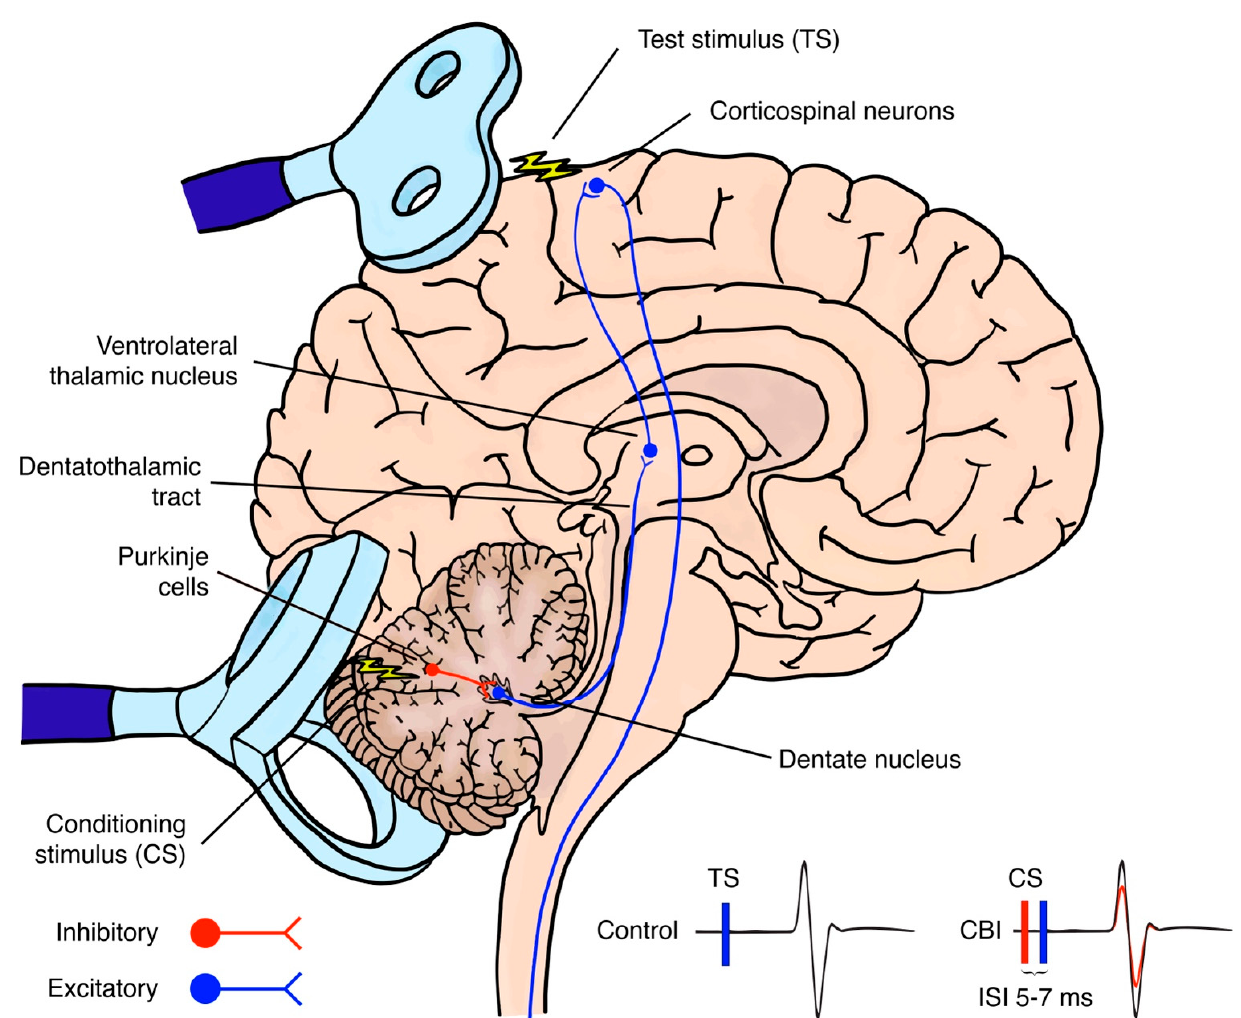
Figure 1. Midsagi tt al section illustrating the cerebellar brain inhibition paradigm. This paired-pulse transcranial magnetic stimulation protocol assesses the physiological inhibitory tone of the cerebellar cortex over the contralateral primary motor cortex. Specifically, the administration of a conditioning stimulus over one of the cerebellar hemispheres within a time interval of 5 to 7 ms prior to a test stimulus over the contralateral primary motor cortex leads to a decrease in motor-evoked potential amplitude.